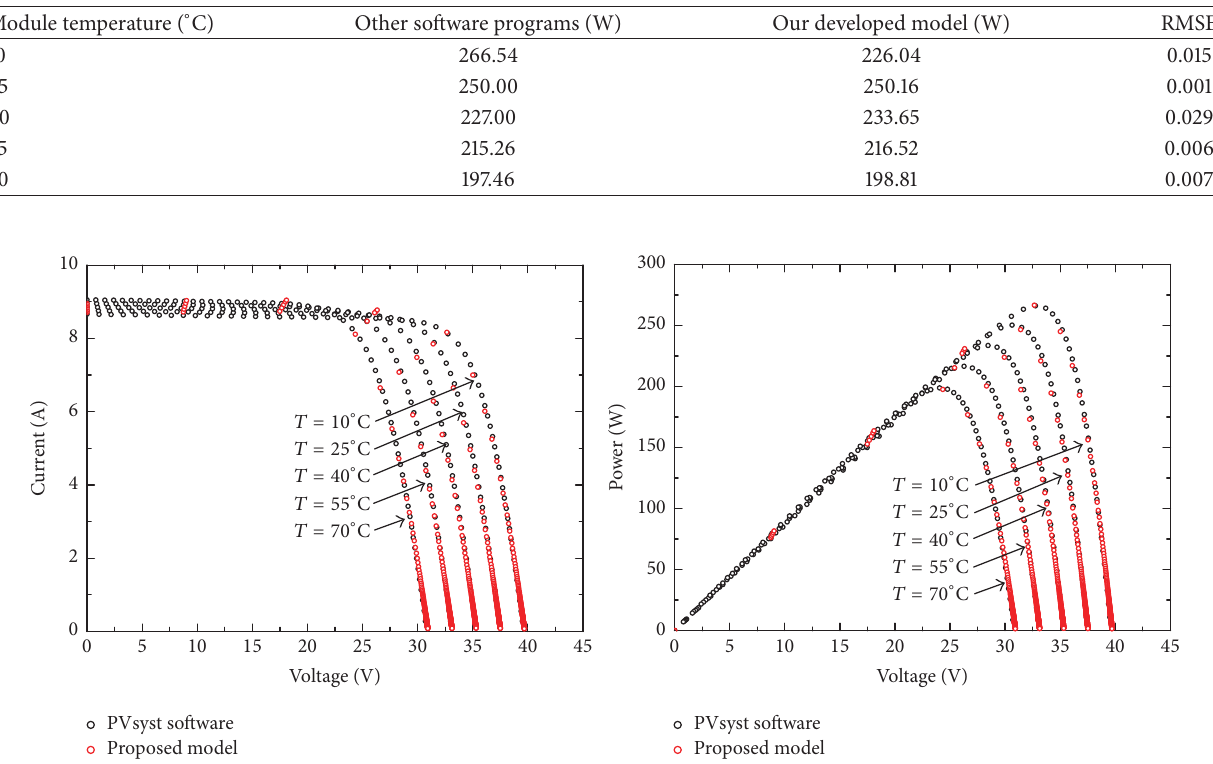
Table 5: Comparing the simulation results with other software programs by varying the module temperature.